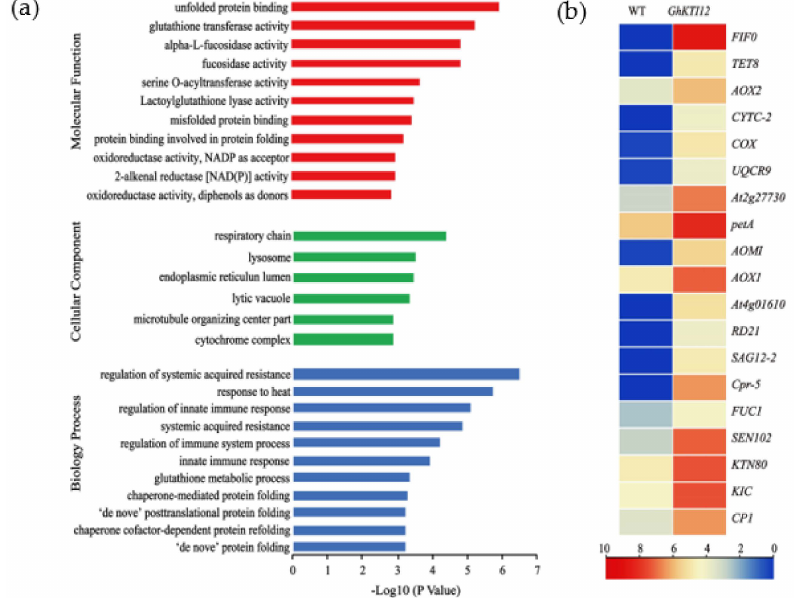
Figure 6. Analysis of upregulated genes in GhKTI12 transgenic plants. GO Histogram of Annotated ( a ) upregulated genes (URGs) in three different functional categories. ( b ) The heat map of DEGs associated with enriched cellular